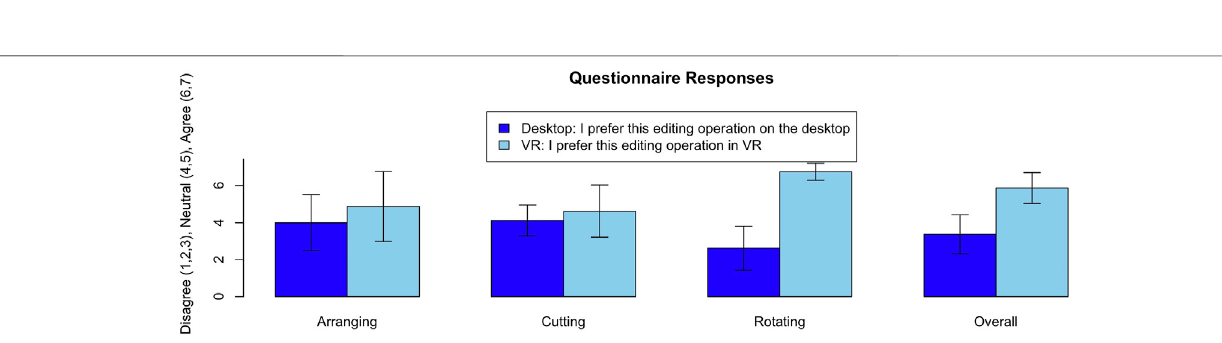
FIGURE13| Thetaskcompletiontimeforeachofthethreetasks.With n (cid:2) 8wefoundnosigni fi cantdifferencesintimesbetweentheVRanddesktopinterfacesfor the three tasks.